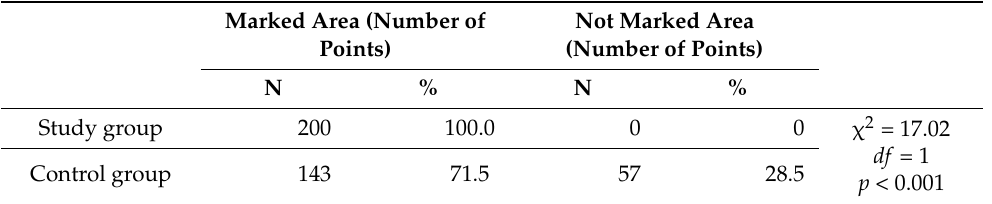
Table 7. Proprietary interactive tactile test “breast self-examination”, and the amount of marked area—Test II. Marked Area (Number of Not Marked Points)